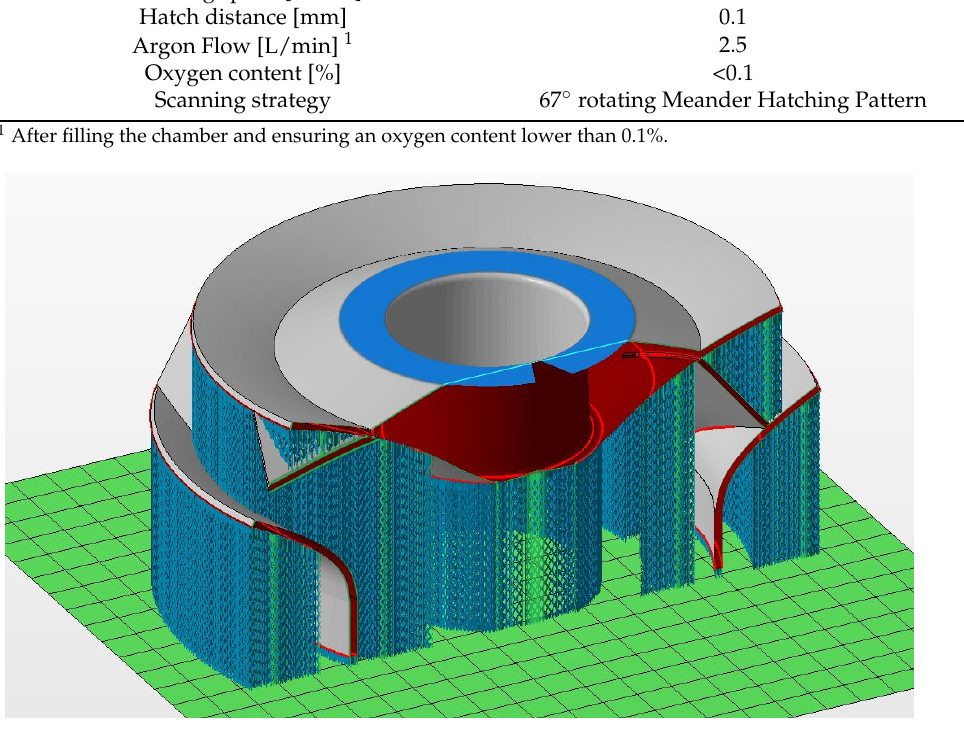
Figure 8. Support structure for the realization of the impeller by using the SLM